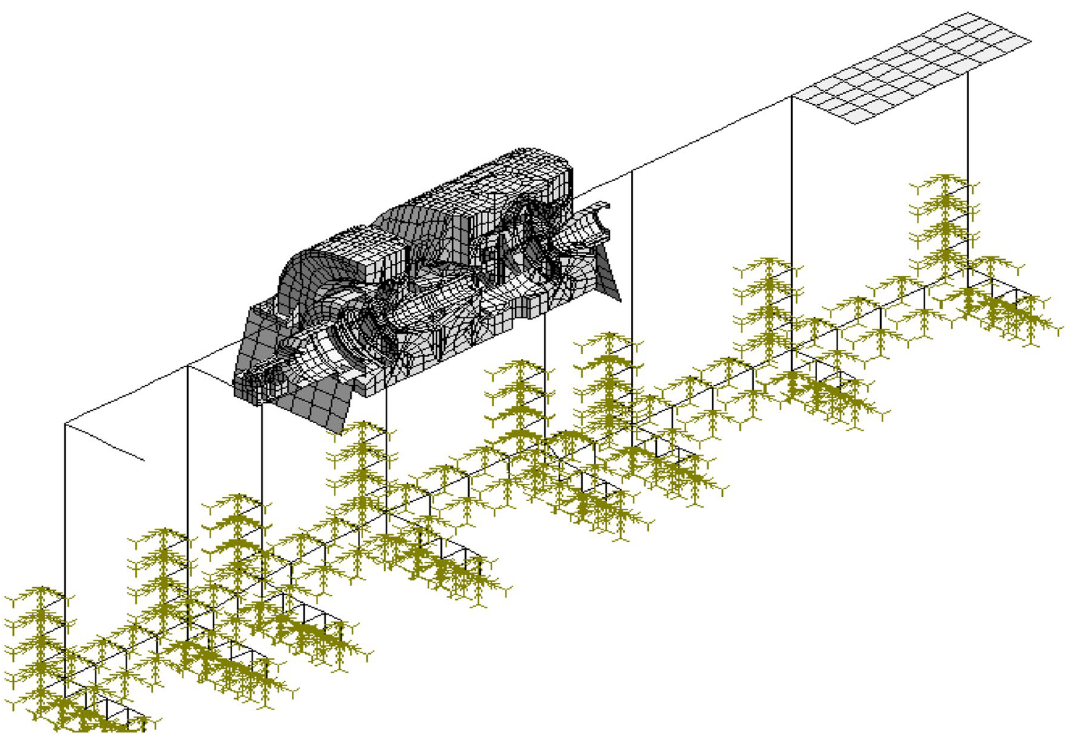
Fig. 8 Model 11, taking into account the rigidity of the soil Fig. 9 Geometric model with